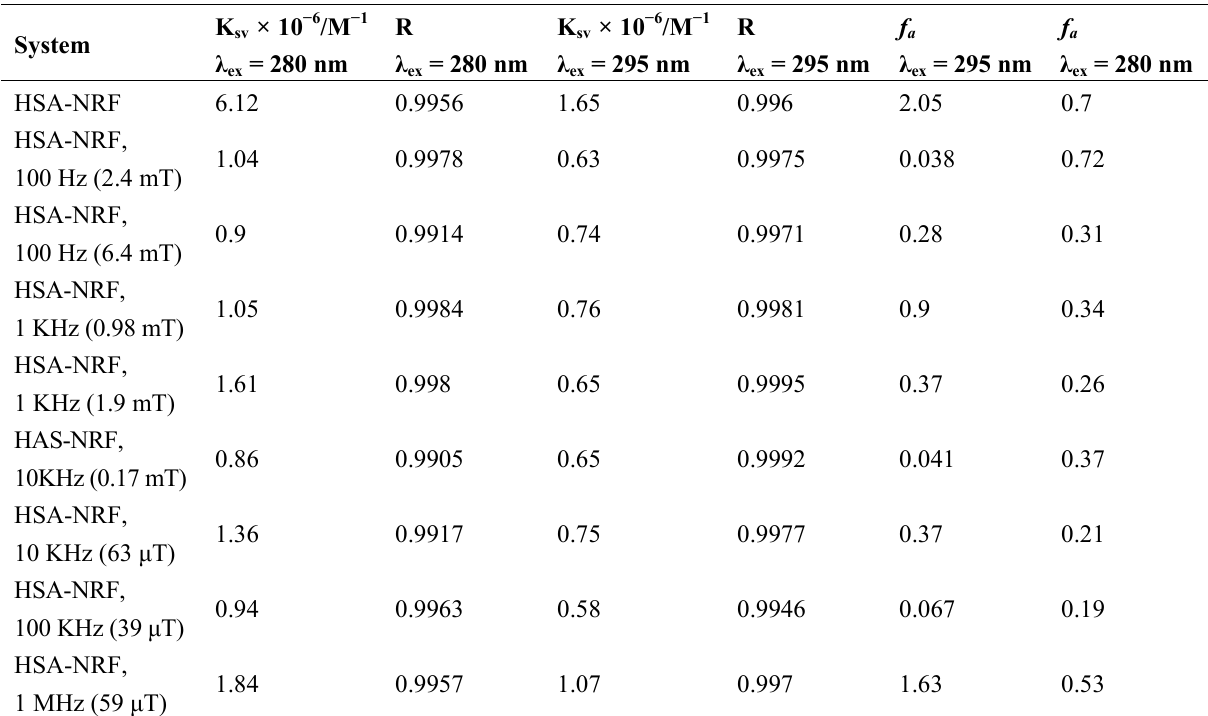
Table 1. Stern-Volmer quenching constants for the interaction of norfloxacin with HSA at various